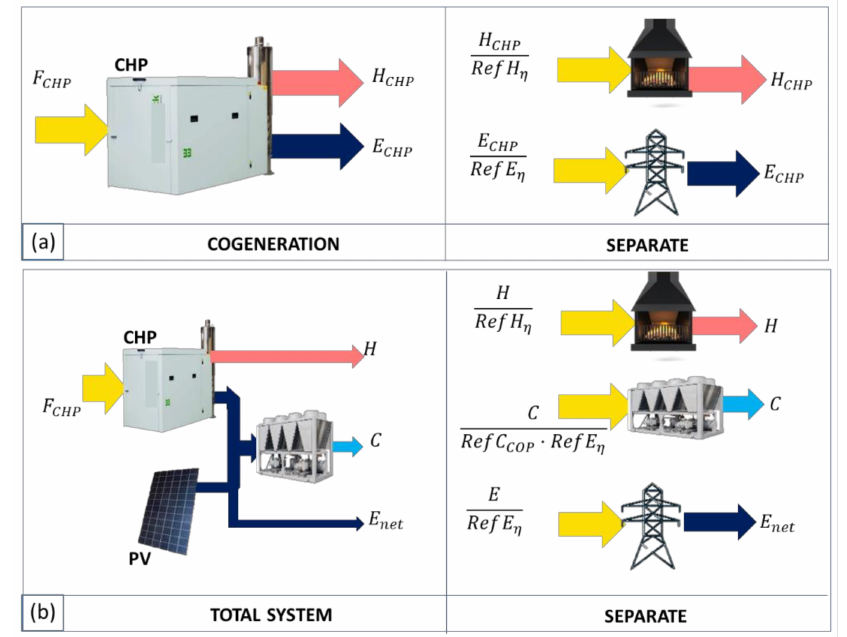
Figure 4. Comparison between combined generation and separate reference generation in ( a ) cogen- eration and ( b ) total